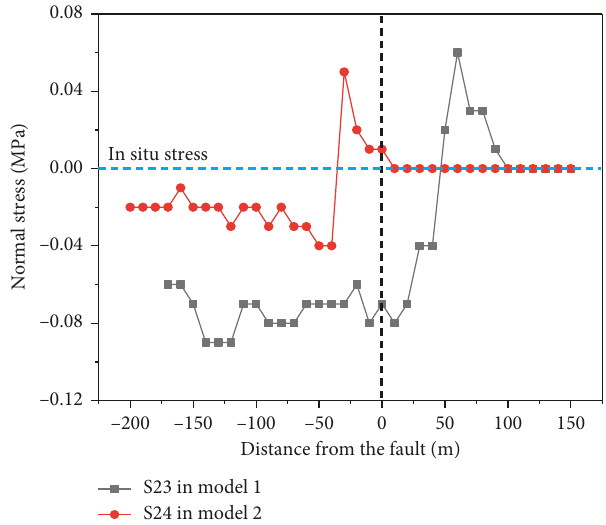
Figure 8: Variation curves of normal stress for the fault